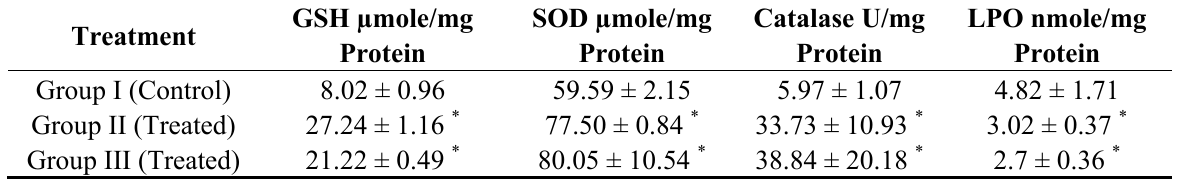
Table 2. Effect of rutinon oxidative enzyme levels.